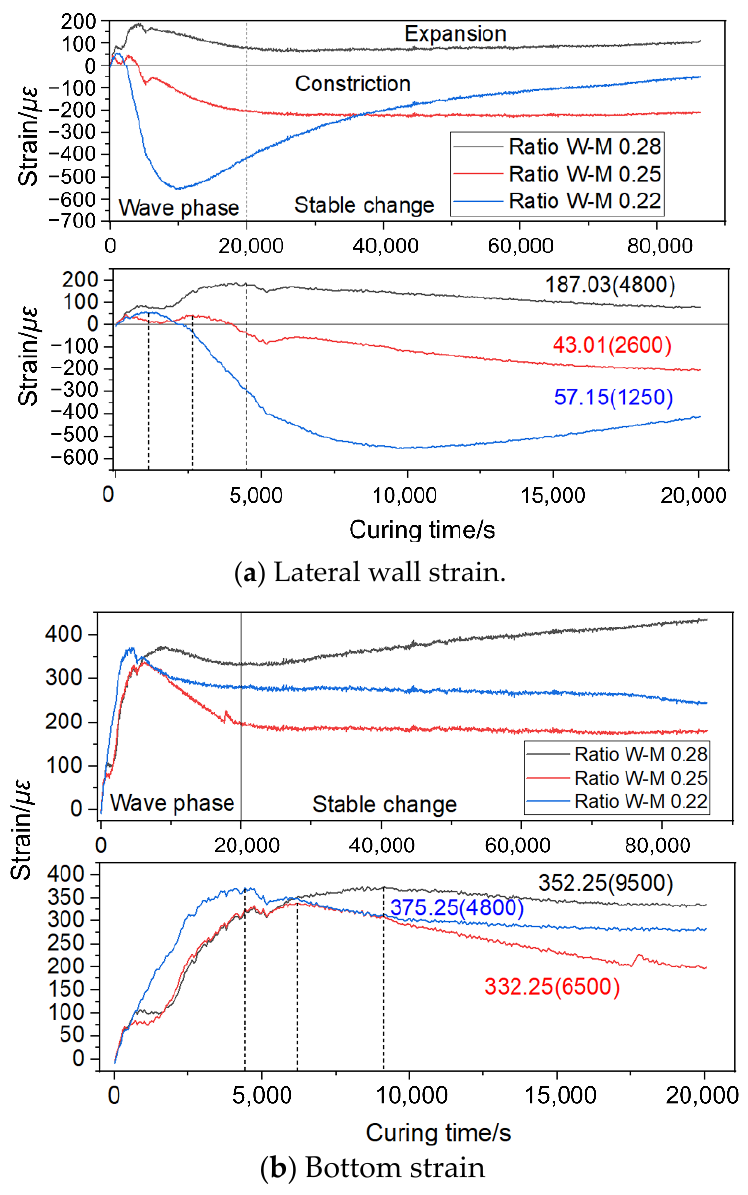
Figure 9. Free solidification strain under different water-to-material ratios.